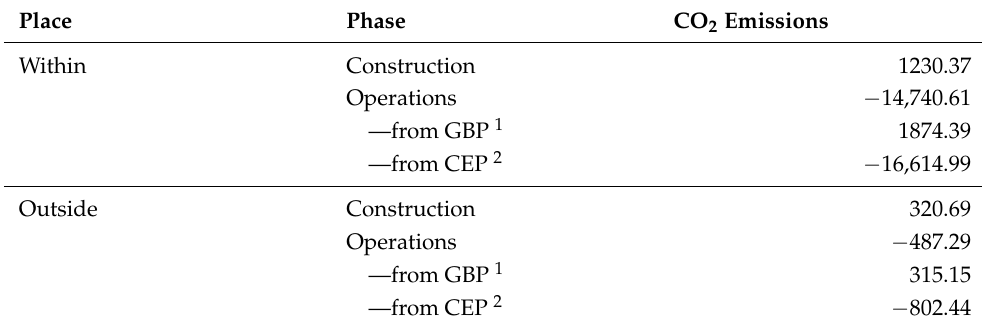
Table 3. CO 2 emission caused by economic effects with carbon neutrality (unit: t-CO 2 ). Place